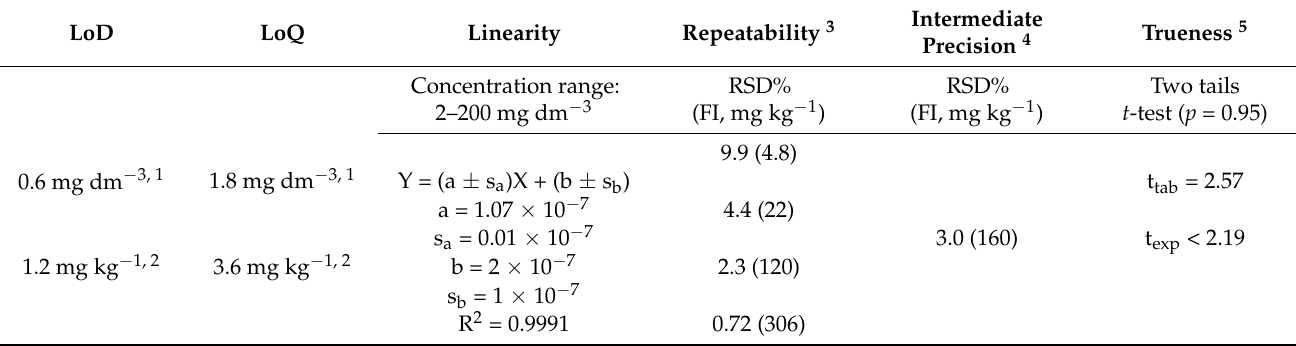
Table 6. Validation parameters for the SWV determination of the furanic index (FI) in honey. LoD LoQ